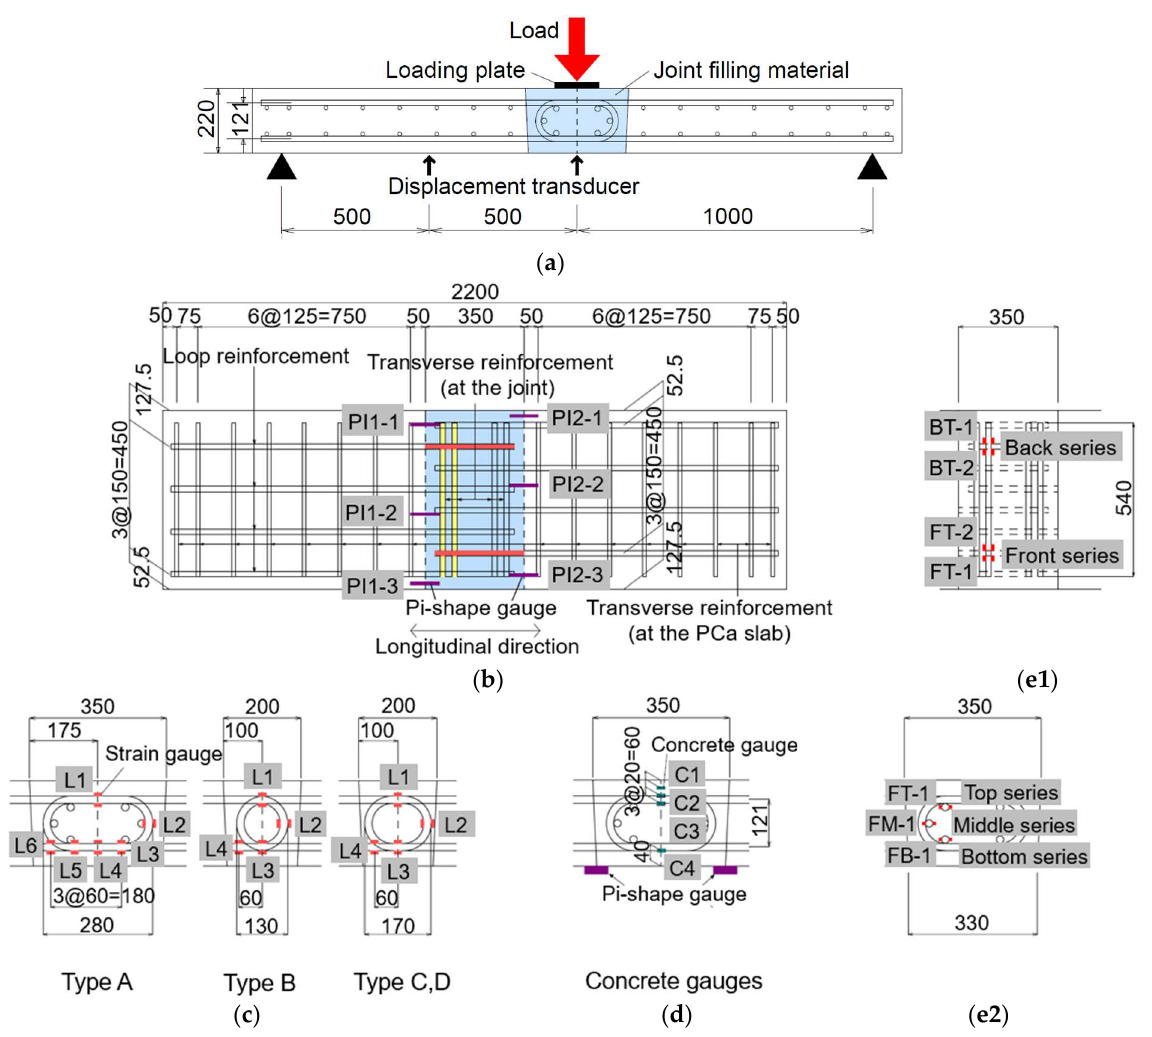
Figure 5. Test setup and specimen details: ( a ) side view; ( b ) plan view: from bottom of specimen and reinforcements whose strains were measured (red: loop reinforcements, yellow: transverse reinforcements and Pi-shape gauge locations; ( c ) strain gauge locations of loop reinforcements; ( d ) concrete gauge locations; ( e1 , e2 ) strain gauge locations of transverse reinforcements in Type A loop joint.